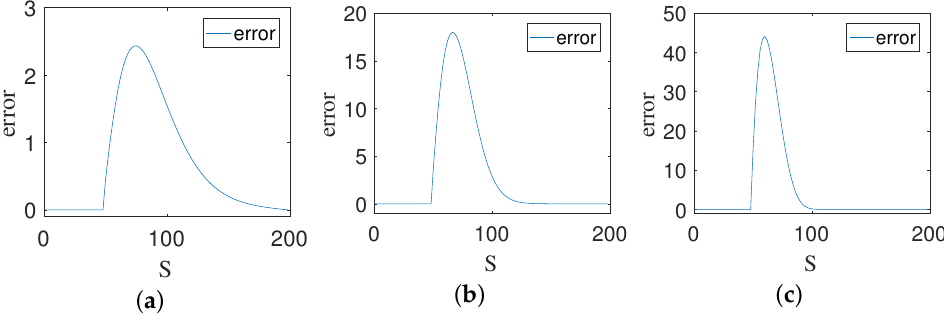
Figure 4. ( a ) denotes | kv − v | for different S when H = 0.3, ( b ) denotes | kv − v | for different S when H = 0.5 and ( c ) denotes | kv − v | for different S when H =